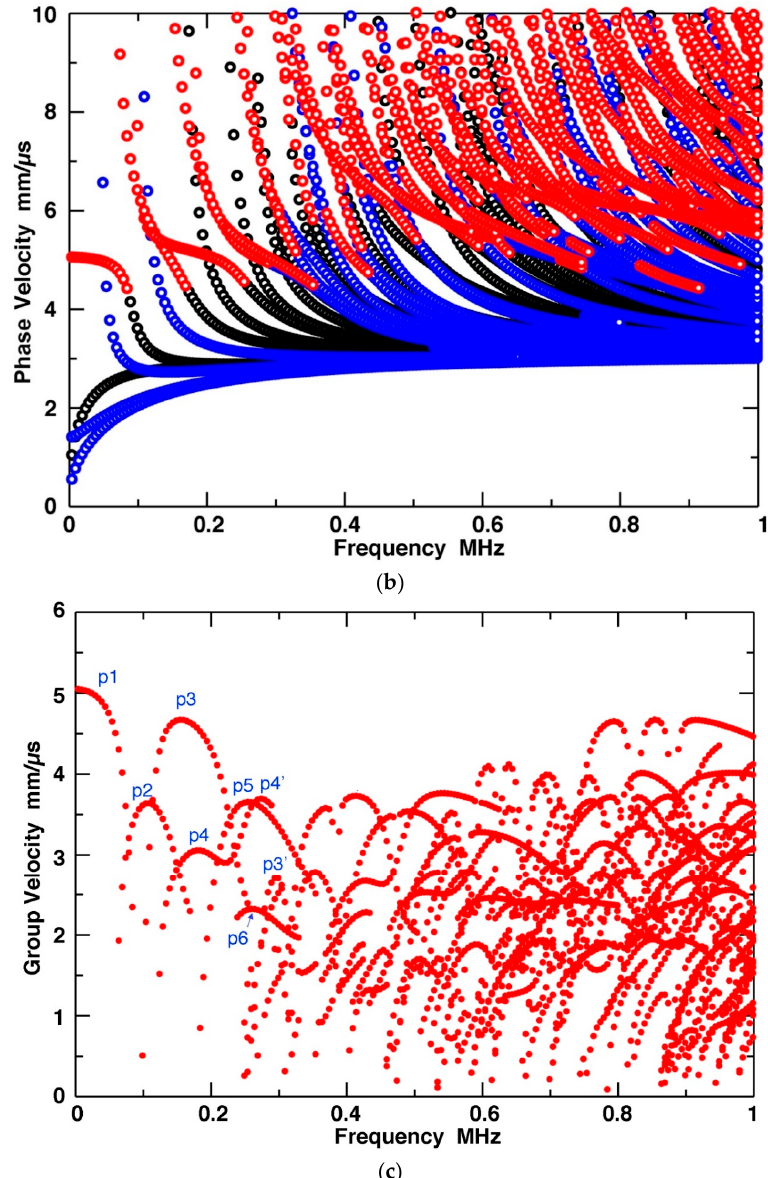
Figure 5. ( a ) Dispersion curves of group velocity vs. frequency for bar waves calculated using Hayashi’s theory and semi-analytical finite-element (SAFE) algorithm [9]. Red points represent the modes dominated by z-direction displacement, blue points those by y-direction displacement and black points those by x-direction displacement. The group velocity of S 0 -mode plate wave for 6.4 mm-thick Al is drawn in as a black curve; ( b ) The corresponding phase velocity dispersion curves; ( c ) The group velocity vs. frequency for bar-wave modes dominated by z-direction displacement. Some peak positions are noted by p1 through p6.